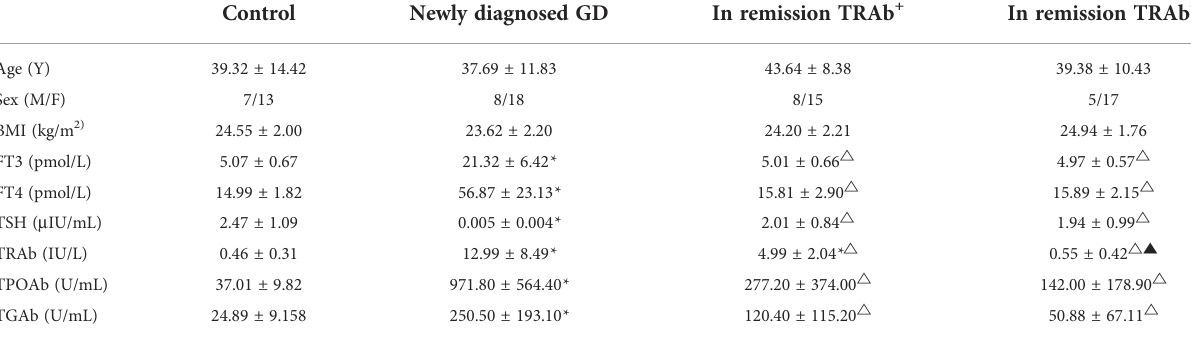
TABLE 2 Clinical characteristics and thyroid parameters of patients with Graves ’ disease (GD) and controls.